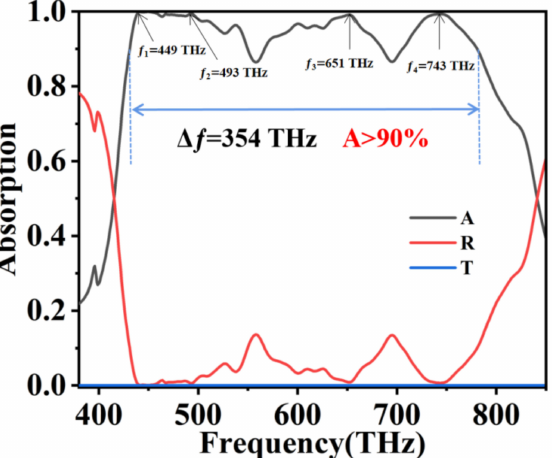
Figure 2. Spectral absorption diagram of the designed absorber in the visible band (TE mode, vertical incidence).